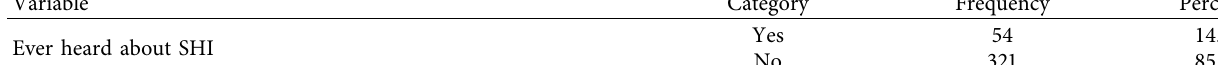
Who do you think should pay for insurance